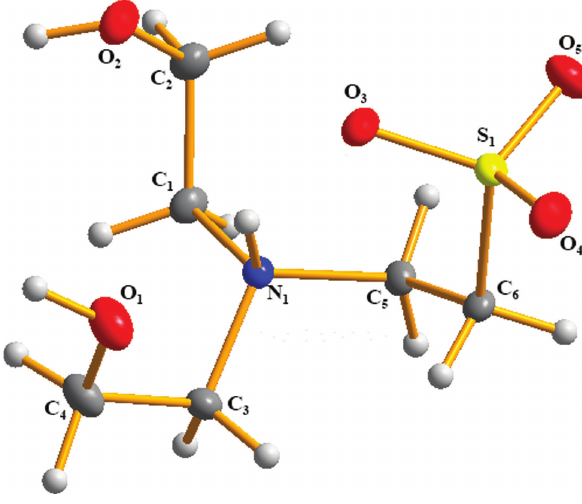
Table 1: Data collection and handling.